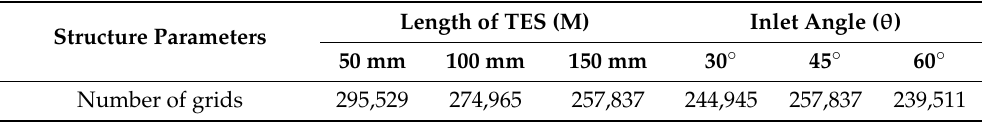
Table 1. Numbers of grids corresponding to various structure